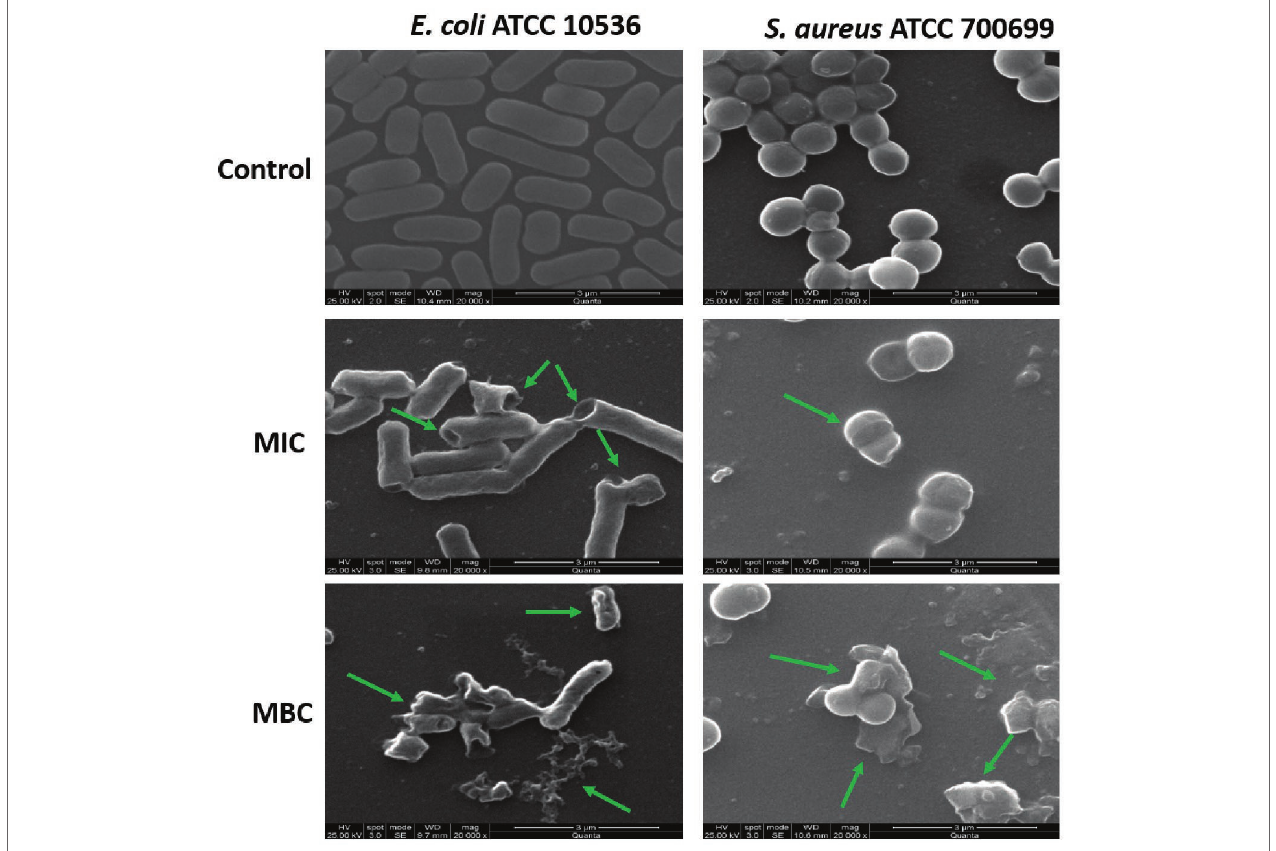
FIGURE 6 | SEM images of S. aureus (ATCC 700699) and E. coli (ATCC 10536) as untreated (control) and treated with minimum inhibitory concentration (MIC) and minimum bactericidal concentration (MBC) of hydroxyapatite– A. indica (HA-AI)